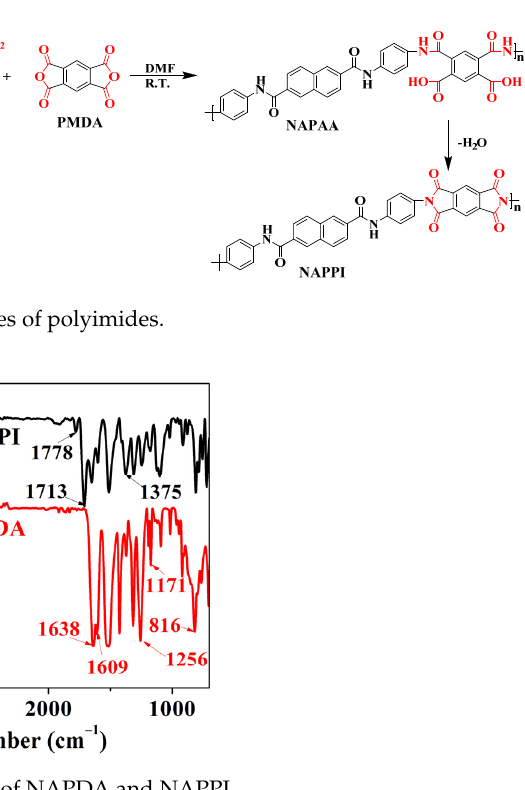
Figure 4. FT-IR spectrum of NAPDA and NAPPI.